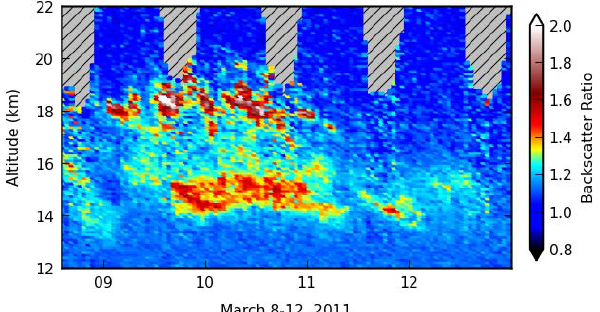
Fig. 4. Backscatter ratio at 532nm as measured by the CRL for 8 to 12 March. The hashed areas represent data that were considered to be